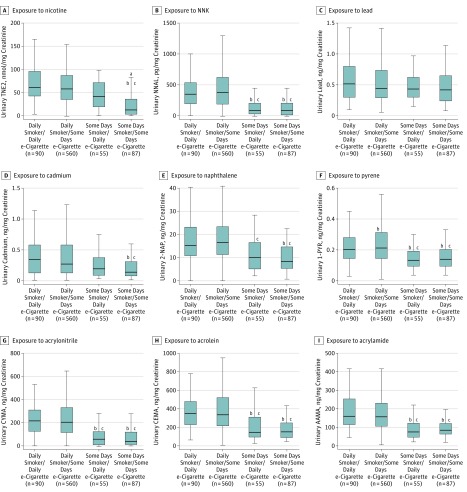
Biomarkers of Exposure Among Dual Users of Tobacco Cigarettes and e-Cigarettes, Population Assessment of Tobacco and Health Study, Wave 1, 2013-2014 (n = 792)Exposure to nicotine (TNE2) (A), tobacco-specific nitrosamine 4-(methylnitrosamino)-1-(3-pyridyl)-1-butanone (NNK) (B), lead (C), cadmium (D), naphthalene (2-naphthol) (2-NAP) (E), pyrene (1-hydroxypyrene) (1-PYR) (F), acrylonitrile (CYMA) (G), acrolein (CEMA) (H), and acrylamide (AAMA) (I). All analyses are weighted. Some volatile organic compound laboratory results were outstanding at the time these analyses were conducted, so weighted estimates may not accurately reflect values in the target population. Mean number of cigarettes per day (CPD) in everyday smokers/everyday e-cigarette users was 15.9 (95% CI 13.8-18.1); some days smokers/everyday e-cigarette users, 14.3 CPD (on days smoked) (95% CI 4.6-24.0 CPD); everyday smokers/some-days e-cigarette users, 16.2 CPD (95% CI, 15.5-16.9); and some-days smokers/some-days e-cigarette users, 6.1 CPD (on days smoked) (95% CI, 4.2-8.0 CPD). Box depicts median and interquartile range; whiskers depict minimum and maximum values for creatinine level–corrected biomarker values across tobacco user groups. Outliers excluded from figure to facilitate presentation clarity.aDenotes estimate with relative SE greater than 30%.bStatistically significant difference from everyday smokers/some days e-cigarette users adjusted for urinary creatinine level, CPD, age, sex, race/ethnicity, educational level, secondhand smoke exposure, and past 30-day marijuana use.cStatistically significant difference from everyday smokers/everyday e-cigarette users adjusted for urinary creatinine level, CPD, age, sex, race/ethnicity, educational level, secondhand smoke exposure, past 30-day marijuana use, and tobacco use status.